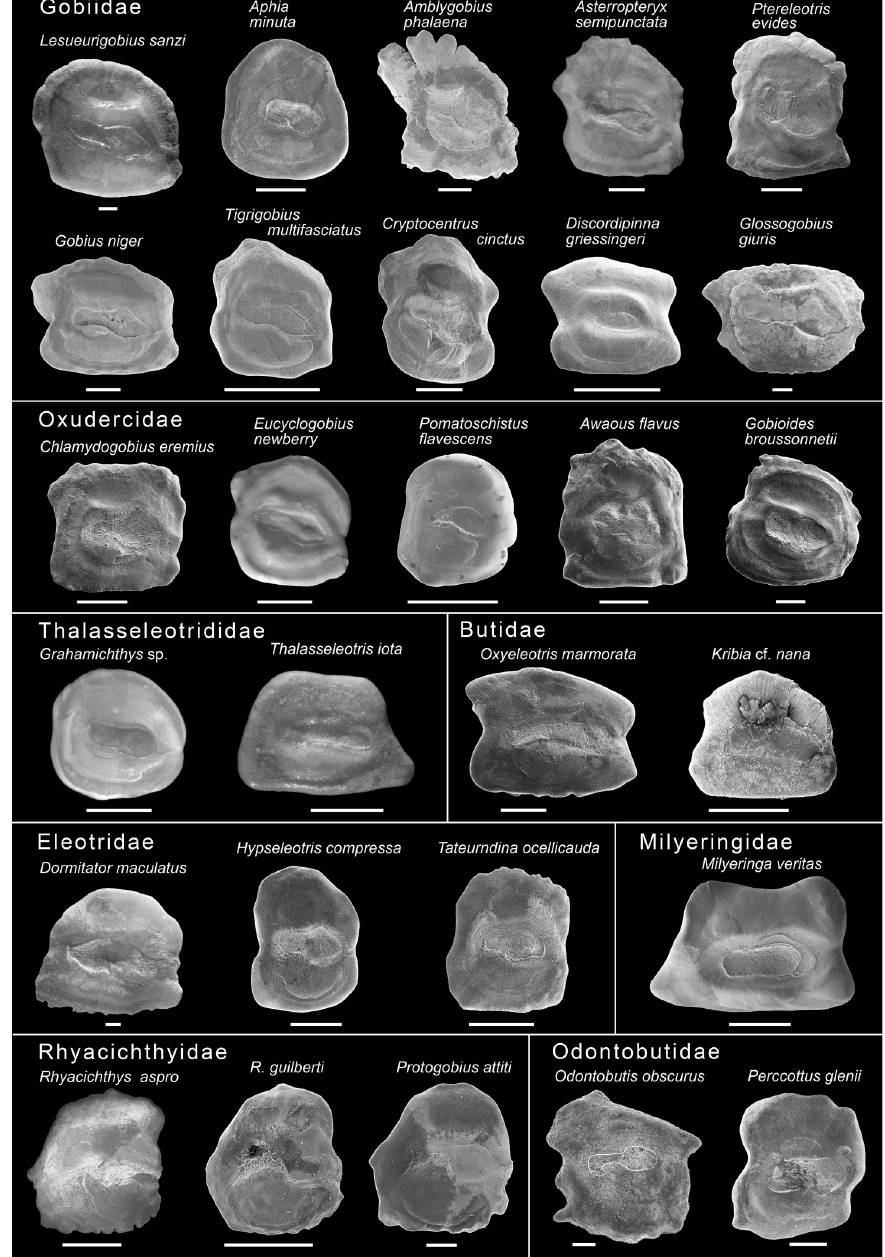
Fig 3. Otoliths of the extant gobioid species used in this study. Images depict left otoliths (sagittae) in medial view, except for Lesueurigobius sanzi , Aphia minuta , Asterropteryx semipunctata , Dormitator maculatus and Odontobutis obscurus , which represent right sagittae that were mirrored for better comparison. Otoliths were not available for the milyeringid Typhleotris madagascariensis . For sources of otoliths see Table 1. Scale bars: 0.5